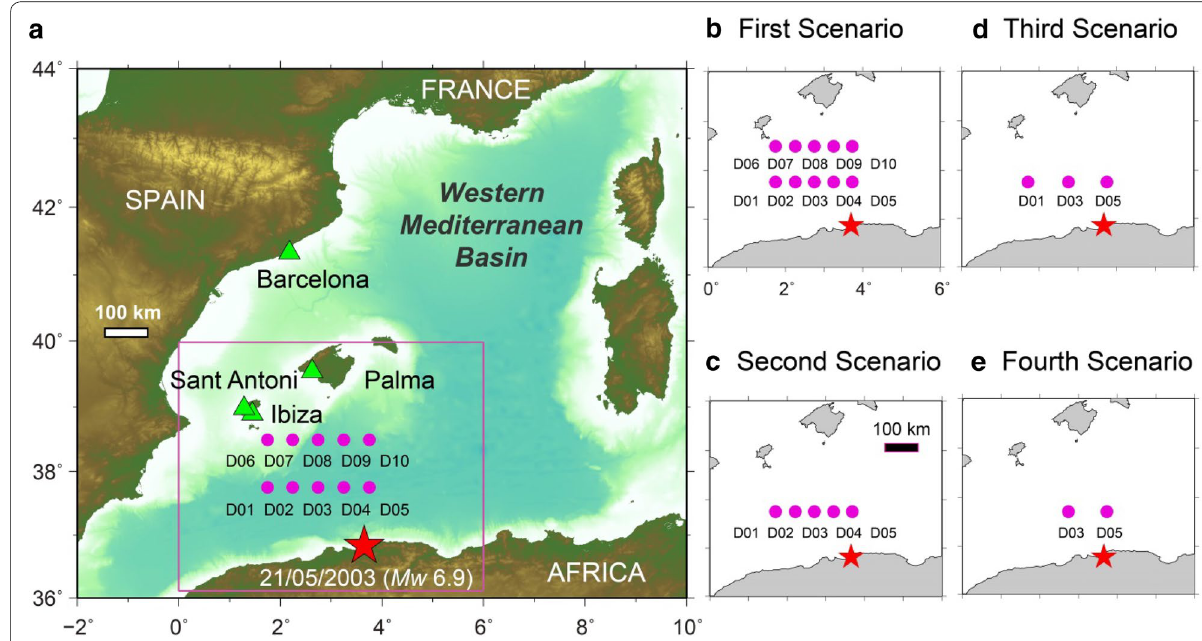
Fig. 4 Different tsunami data assimilation scenarios employing 10, 5, 3 and 2 offshore tsunami pressure gauges (pink solid circles). Triangles and the star show the locations of tide gauges and the May 2003 epicenter,